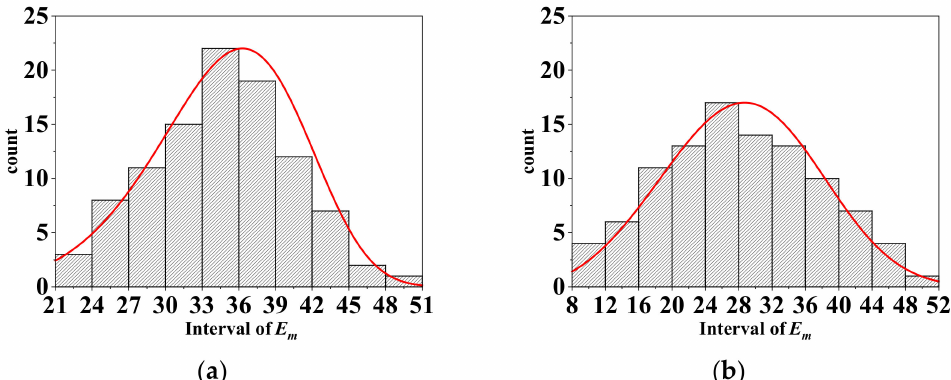
Figure 15. Histogram of frequency. ( a ) N = 0. ( b ) N = 125.